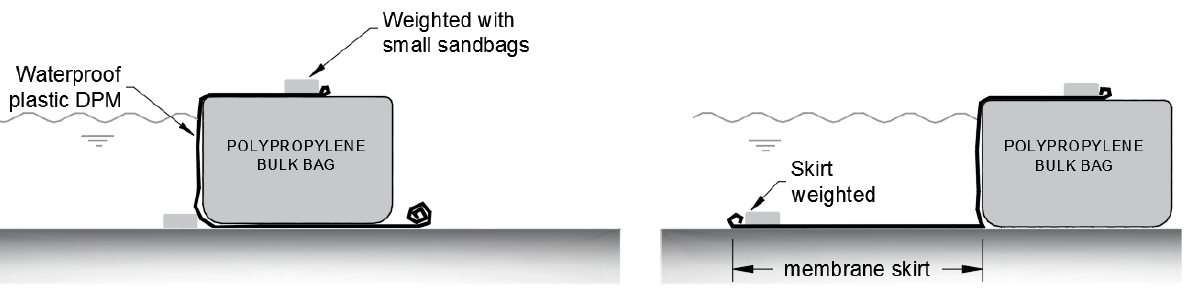
Figure 9. Cross-sectional illustration of the singular bulk bag with DPM.